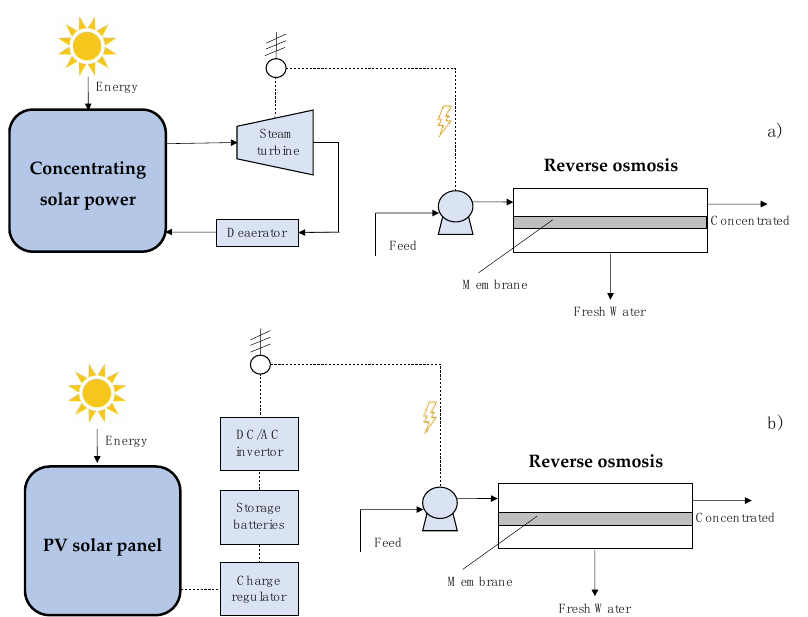
Figure 5. Schematic view of ( a ) Concentrating solar power + Reverse osmosis (CSP/RO) plant, ( b ) Photovoltaic solar panel + Reverse osmosis (PV/RO) plant. Geothermal Desalination (GD)